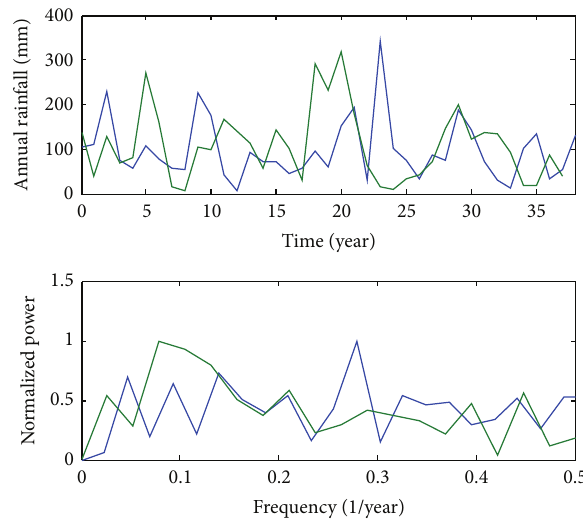
Figure 10: Normalized power spectrum estimated from annual rainfall using Fast Fourier Transform analysis (blue line: 1934–1976; green line: